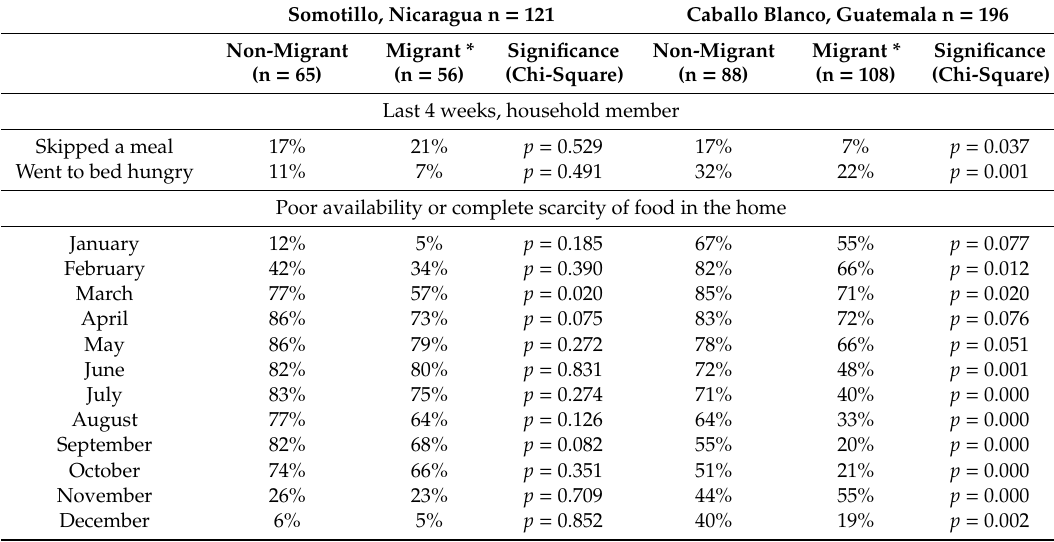
Table 2. Hunger in the Case Study